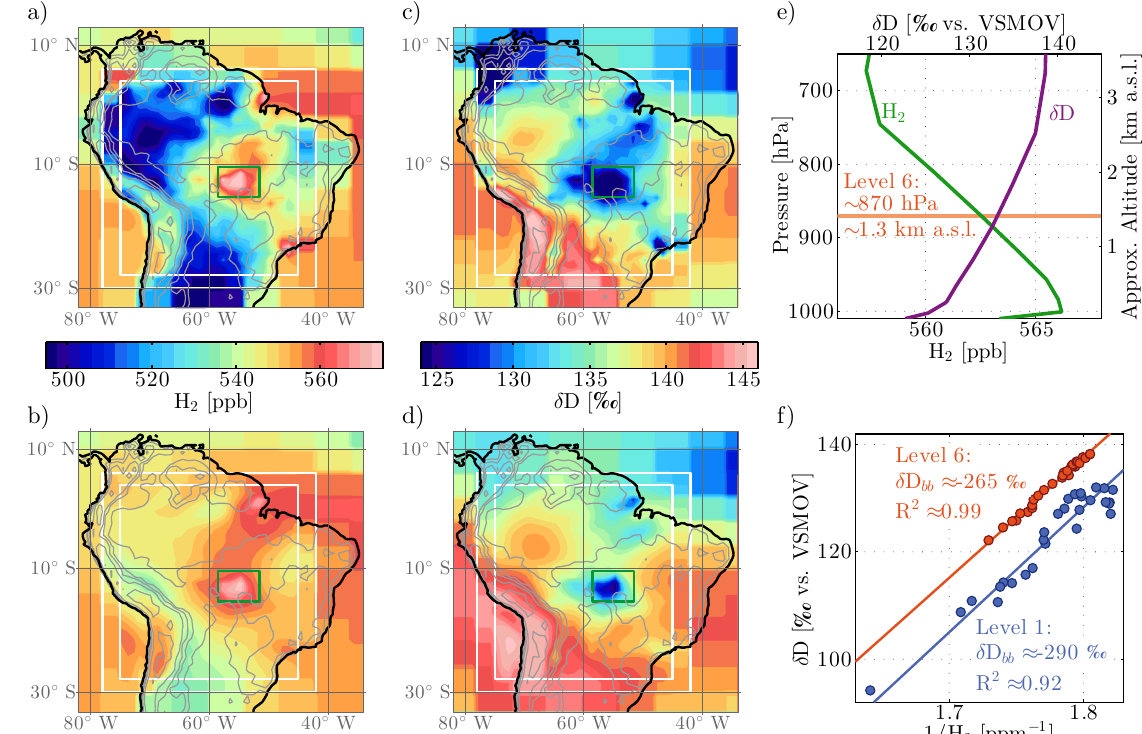
Fig. 4. TM5 results for November and December after five years of integration from the zoom region over the Amazon Basin (white boxes in panels (a) through (d) indicate the boundary of the respective resolutions). Surface emissions are from the year 2003 with a distinct biomass-burning source indicated by the green box in the centre of the domain (panels a through d ). Mean H 2 mixing ratios (a) and (b) , and δ D values (c) and (d) of the lowest (level one, top panels) and sixth lowest (level six, bottom panels) atmospheric model levels. Level six of the model corresponds to about 870hPa or 1.3kma.s.l. (e) Vertical profiles of H 2 and δ D from the spatial mean of the green box. (f) Keeling plot with regression lines of all grid cell values within the green box for level one (blue) and level six (red). The values from level six show the δ D bb signature closest to the input value of − 262‰ and the highest